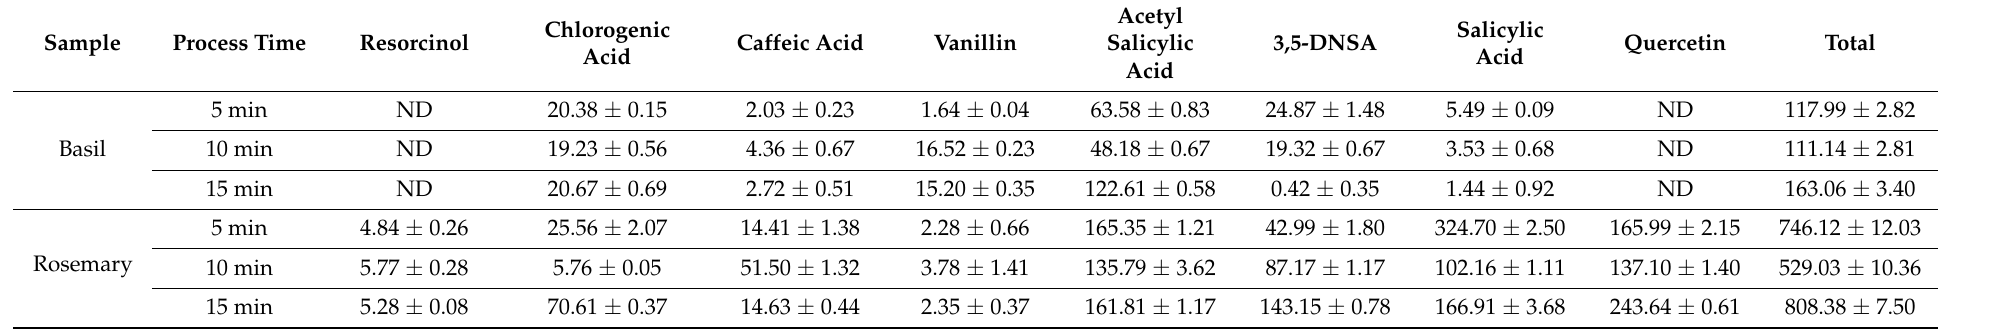
Table 3. Effect of boiling on phenolic compounds of rosemary and basil by HPLC (mg/100 g) dry weight